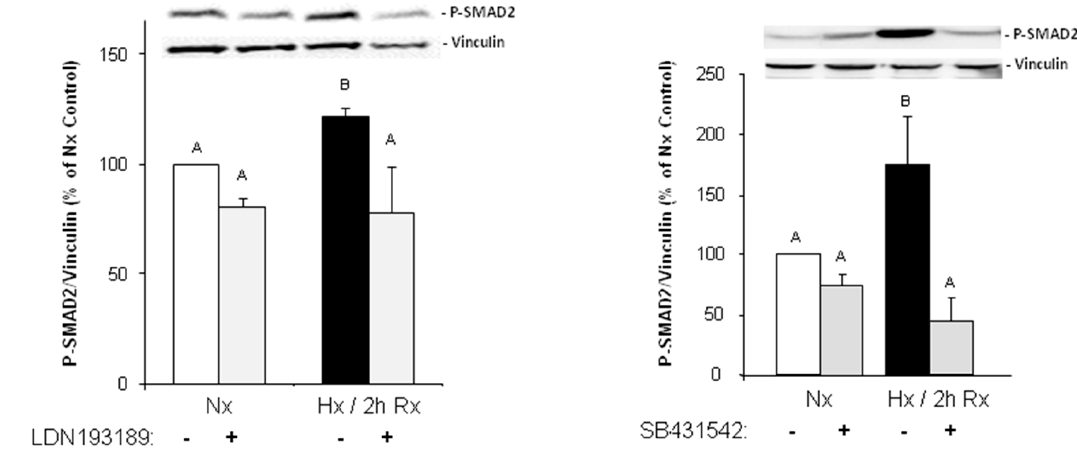
Figure 3. Activation of SMAD-signaling in hypoxic reoxygenated endothelial cells. Endothelial cells were exposed to one hour hypoxia or normoxia (Nx), followed by two or four hours of reoxygenation (Rx) in presence or absence of the ALK1 inhibitor LDN193189 (1 µg/mL) or the ALK5 inhibitor SB431542 (1 µM). Then Western blots were performed using antibodies against phospho-SMAD1/5, phospho-SMAD2, or vinculin as loading control. Representative Western blots, and quantification of protein expression are depicted. For quantification, phospho-SMAD1/5/vinculin or phospho-SMAD2/vinculin ratios are expressed as percent increase relative to normoxic controls, and are means ± SE of n = 13 or n = 3 (for P-SMAD2 ± SB431542) independent culture preparations. Uppercase letters indicate significant differences between groups with p ≤ 0.05.